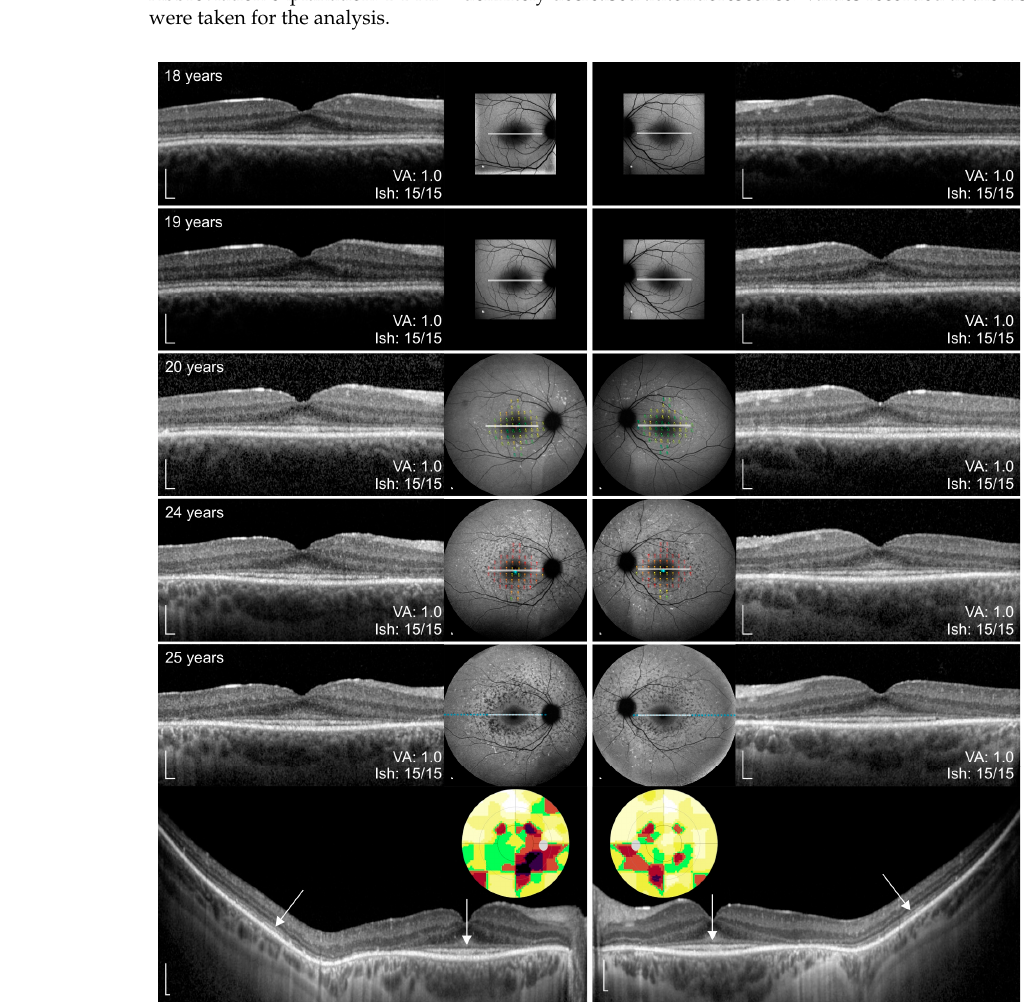
Figure 2. Right eye ( left column ) and left eye ( right column ) spectral-domain optical coherence tomography (OCT) and FAF images of WDR19 patient over the course of 7 years. Age at the exam, best-corrected visual acuity (BCVA) in Snellen, Ishihara color vision are stated on each image. Microperimetry exam is overlaid on FAF images in selected exams. Static perimetry covering central 60° degrees is shown on the bottom. Note the typical signs of Stargardt disease, i.e., peripapillary sparing and hyper-and hypoautofluorescent flecks. Macular atrophy is most notable in the perifoveal area, while fovea is preserved (i.e., foveal sparing). Inner segment ellipsoid (ISe) band is marked with arrows. Abbreviation explanation: VA—visual acuity, Ish—Ishihara plates. Scale bars: 200 µm.